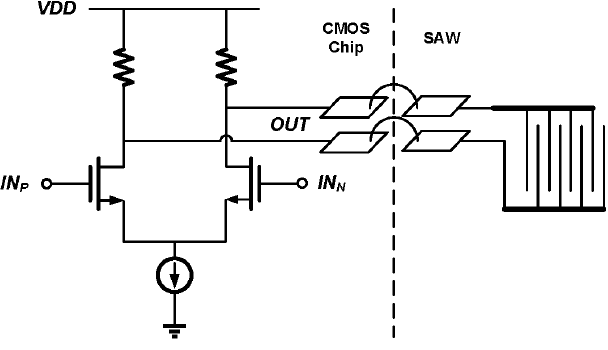
Figure 7. SAW device connected to the driving amplifier in the readout chip using bonding